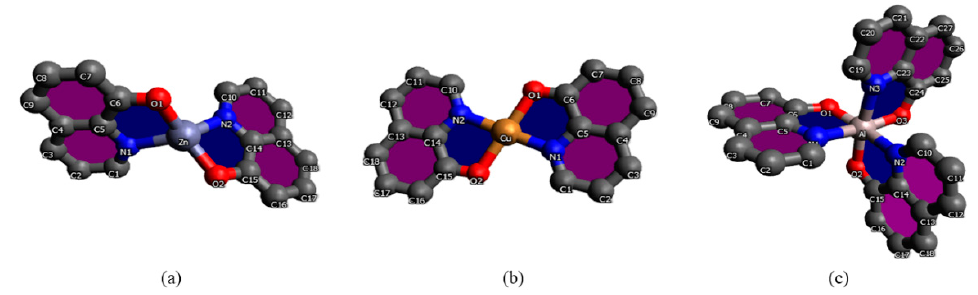
Figure 8. Optimized structures of investigated molecules: ( a ) Znq 2 , ( b ) Cuq 2 , ( c ) Alq 3 .